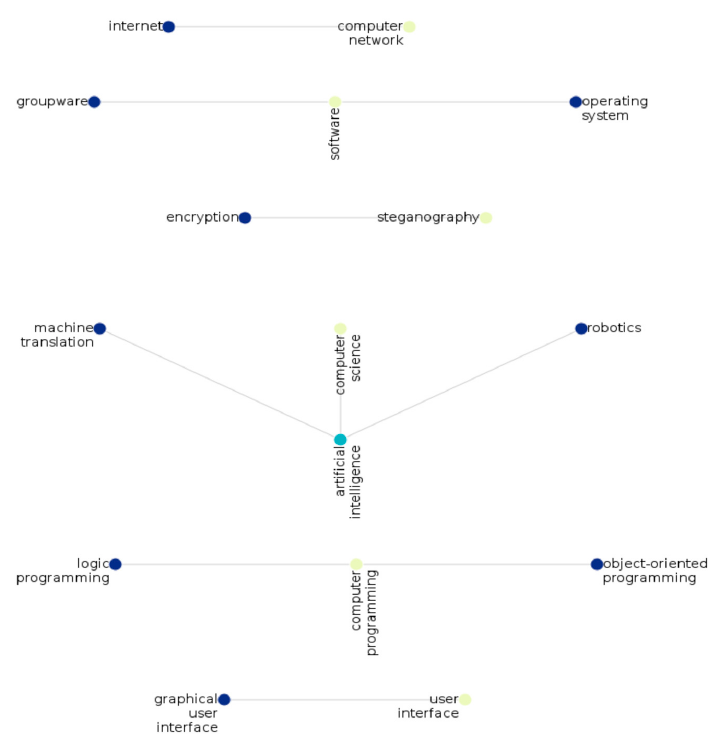
Figure 6. WordNet hierarchy: the illustration represents the connections between different keywords in WordNet.